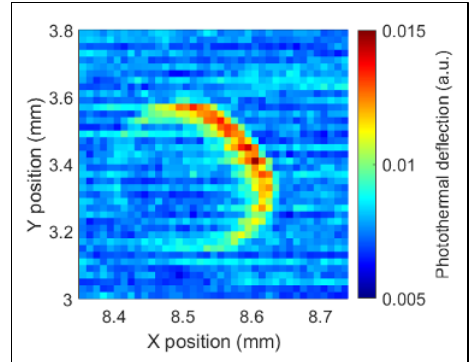
Fig. 5. Example of a PTD mapping over a LIDT site in SiO 2 (for 1064 nm) coated fused silica sample. Scanning area (400 µm) 2 , scanning step 10 µm, PSD gain 10, and average pump power 130